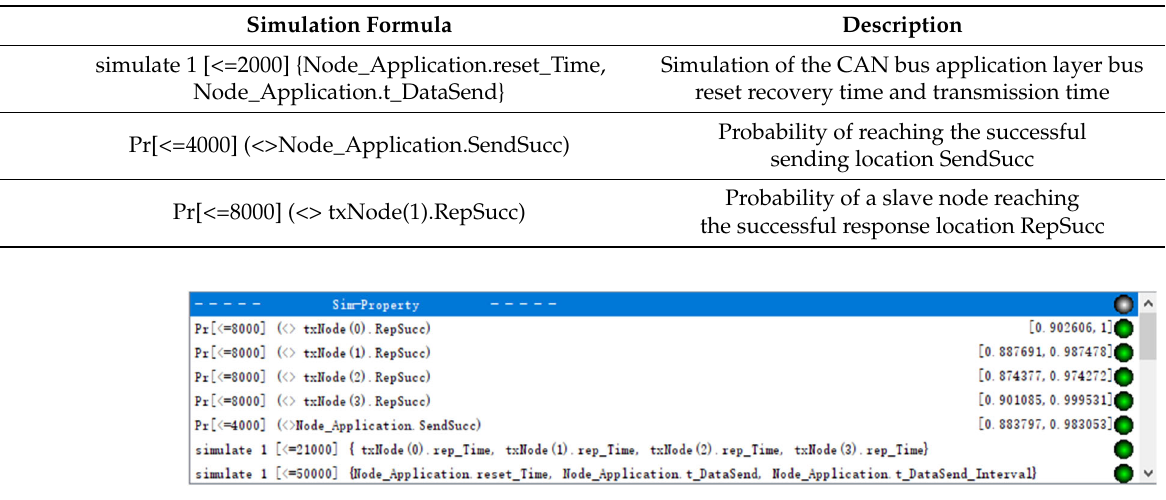
Figure 11. Simulation results in UPPAAL SMC.